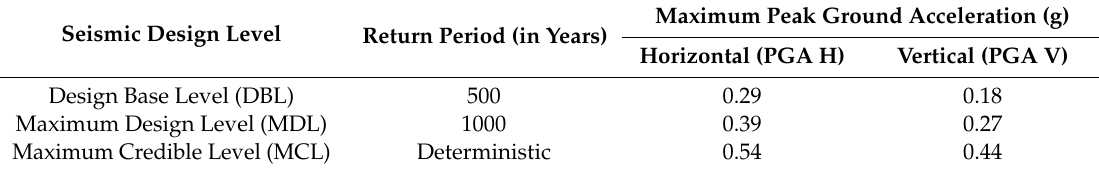
Table 1. Peak ground acceleration (PGA) for different seismic levels.